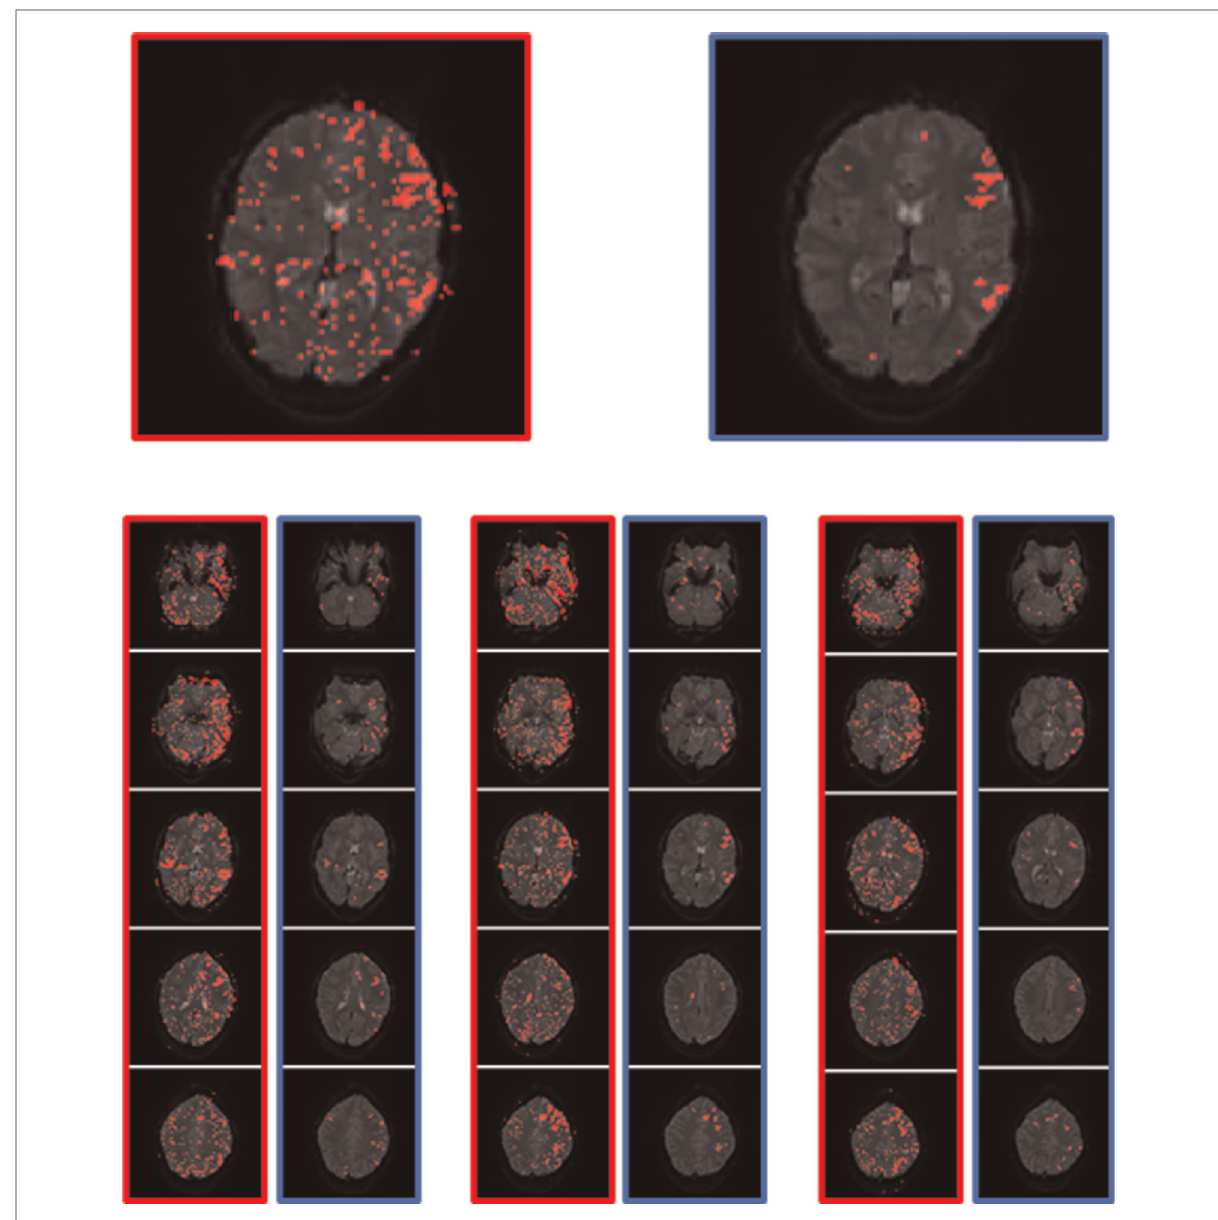
FIGURE 7 Example of the performance of the simple t -map (left, red) and the fi ltered t -map (right, blue). The two images on the top are the magni fi cation of a slice with a good display of the language areas.